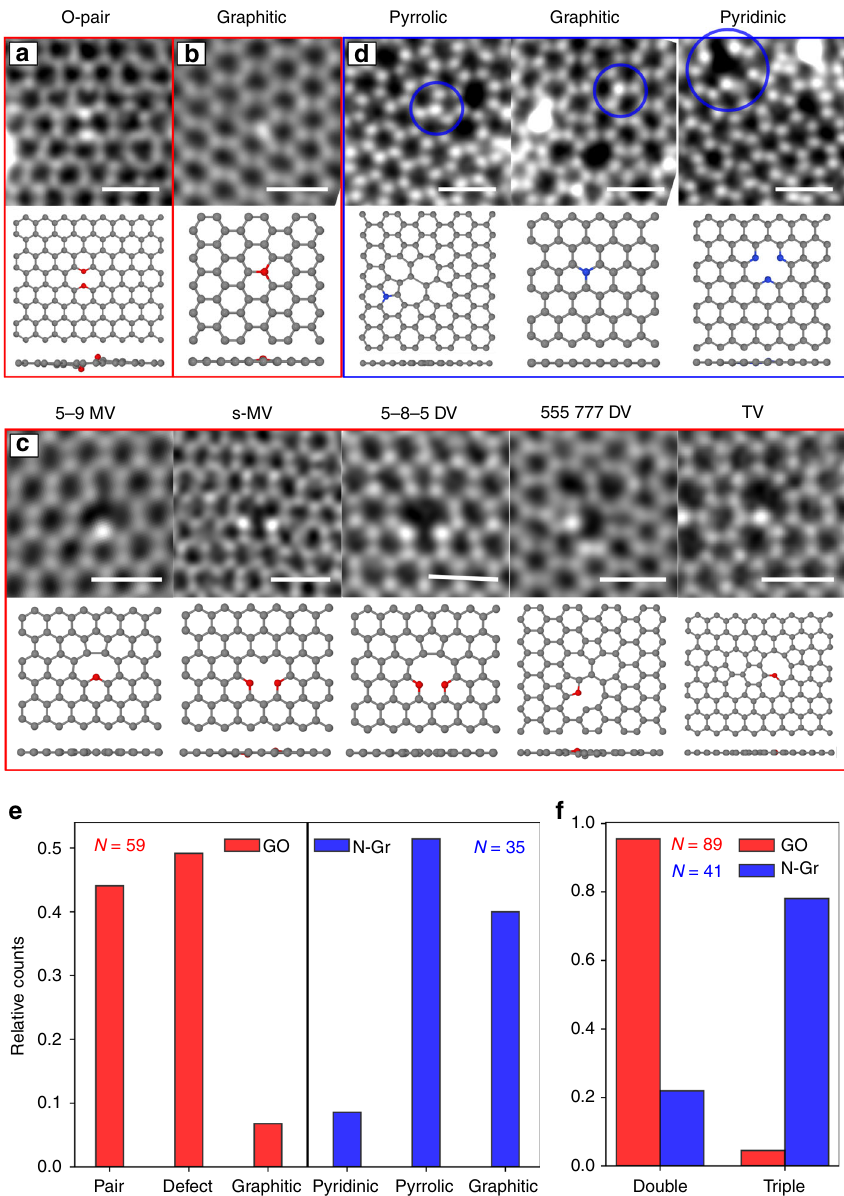
Fig. 2 STEM images of different con fi gurations of oxygen and nitrogen atoms in graphene. a Oxygen pair. b Graphitic substitution by oxygen. c Oxygen atoms within vacancies. d Nitrogen-doped graphene con fi gurations. e Distribution of the different con fi gurations in GO (red) and N-doped graphene (blue). f Distribution of double-coordinated and triple-coordinated heteroatoms in GO (red) and N-doped graphene (blue). N shows the total number of heteroatoms of each sample (note that some con fi gurations contain multiple heteroatoms). Scale bars are 0.5